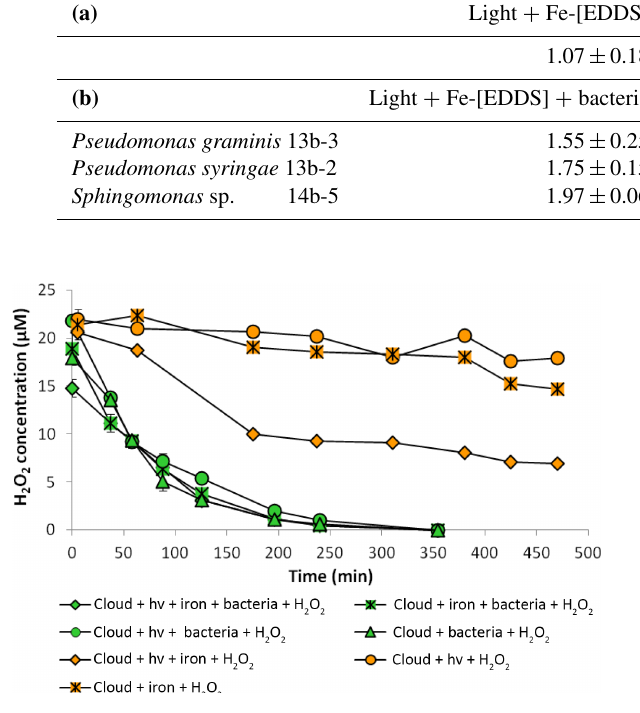
Figure 1. Evolution of H 2 O 2 concentration as a function of time (min) under abiotic conditions: light + Fe-[EDDS] (orange dia- mond), light (orange circle), Fe-[EDDS] (orange square with black cross), and biotic conditions: light + Fe-[EDDS] + Pseudomonas graminis (13b-3) (green diamond), Fe-[EDDS] + Pseudomonas graminis (13b-3) (green square with black cross), light + Pseu- domonas graminis (13b-3) (green circle), and Pseudomonas grami- nis (13b-3) (green triangle). Values shown are averages of triplicates plus/minus 1 standard deviation. Where error bars are not visible, they are smaller than the